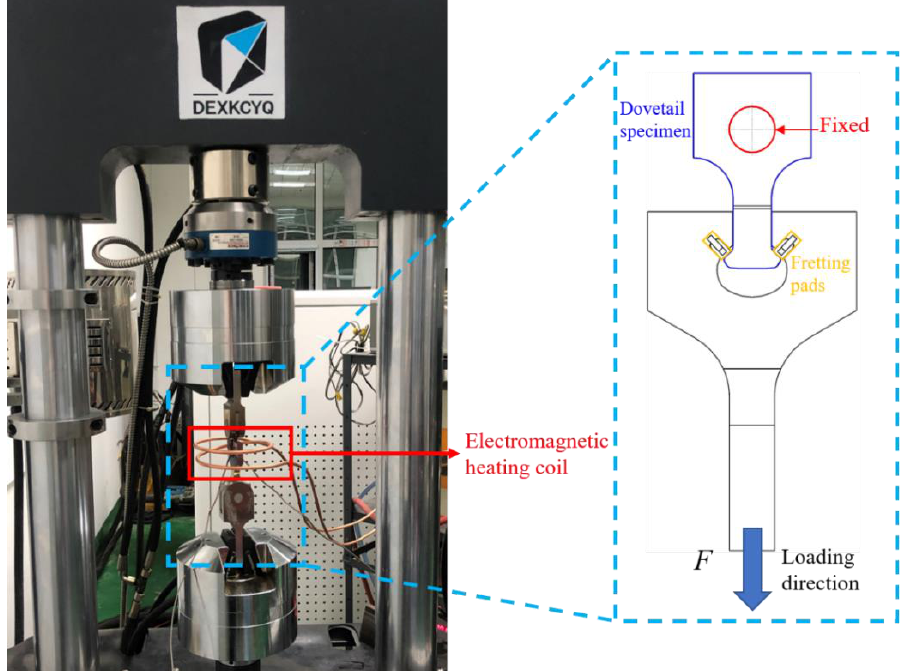
Figure 3. Test equipment for fretting fatigue.